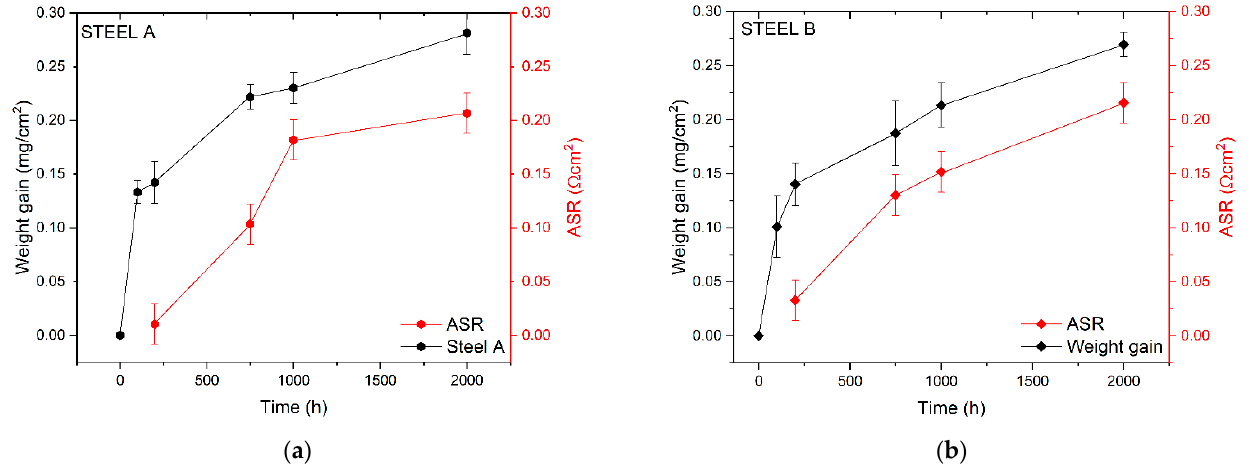
Figure 3. Comparison between weight gain and ASR data for Steel A ( a ) and Steel B ( b ).